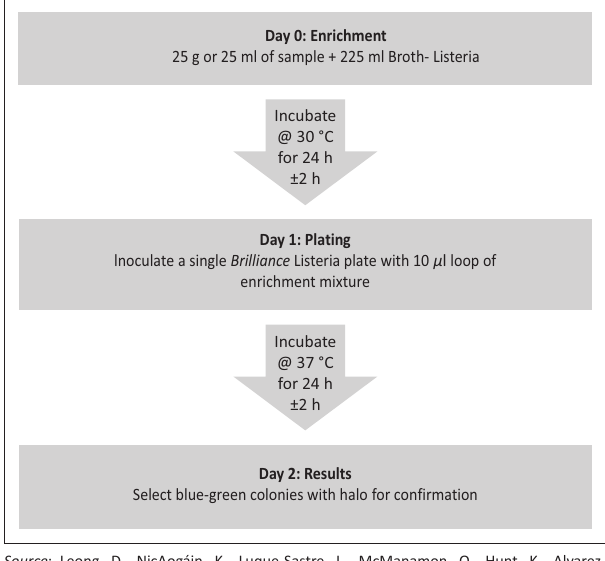
FIGURE 5: The illustration of United States Department of Agriculture method.